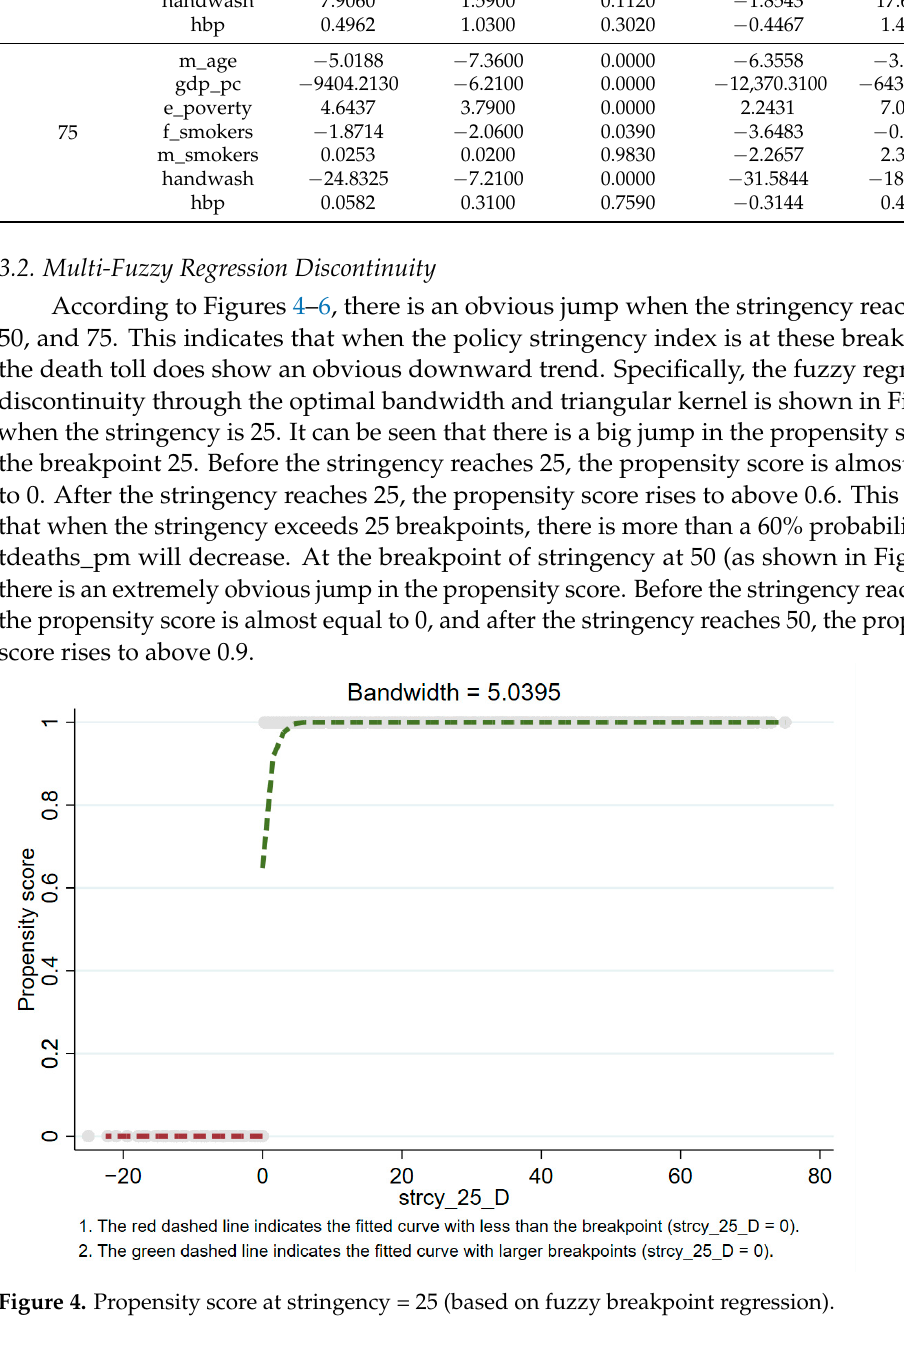
Figure 5. Propensity score at stringency = 50 (based on fuzzy breakpoint regression).